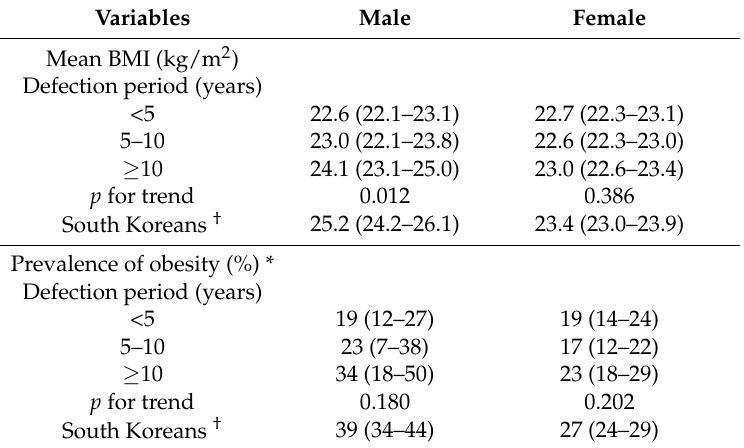
Table 2. The mean BMI and obesity prevalence among NKRs compared with South Koreans.